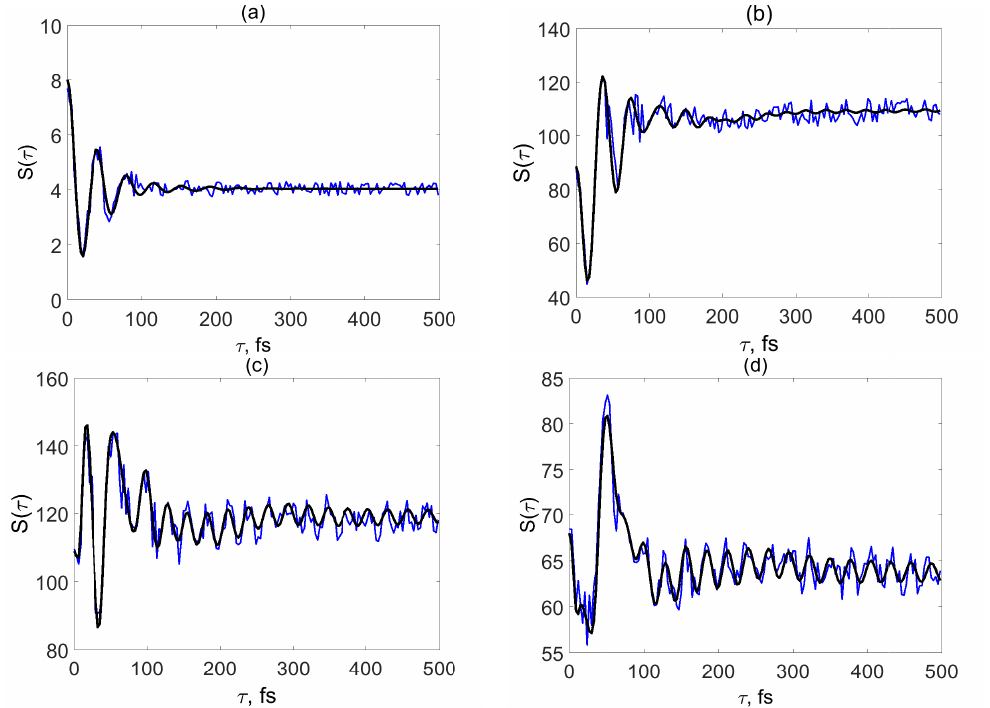
Figure 3. Model II. SM signals for different system-field couplings. η 02 = 0.01 eV ( a ), 0.09 eV ( b ), 0.17 eV ( c ) and 0.19 eV ( d ). Black lines show the SM signals calculated without parameter modulations. Blue lines depict the SM calculated with modulations of electronic